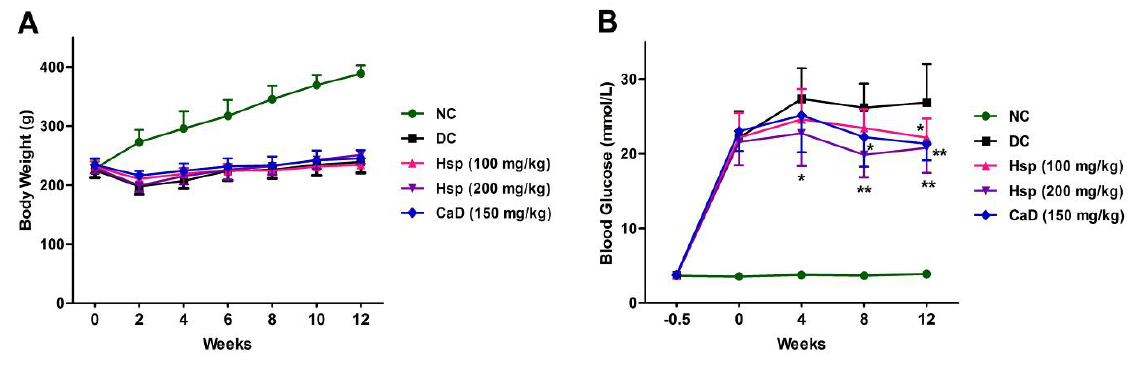
Figure 2. Effects of Hsp and CaD on body weight and blood glucose levels. ( A ) Effects of Hsp and CaD on body weight among different study groups over a duration of 12 weeks in diabetic rats; ( B ) Effects of Hsp and CaD on blood glucose levels over a course of 12 weeks. * p < 0.05, ** p < 0.01 as compared with the DC group; NC, Normal Control; DC, Diabetic Control. The data represent means ±